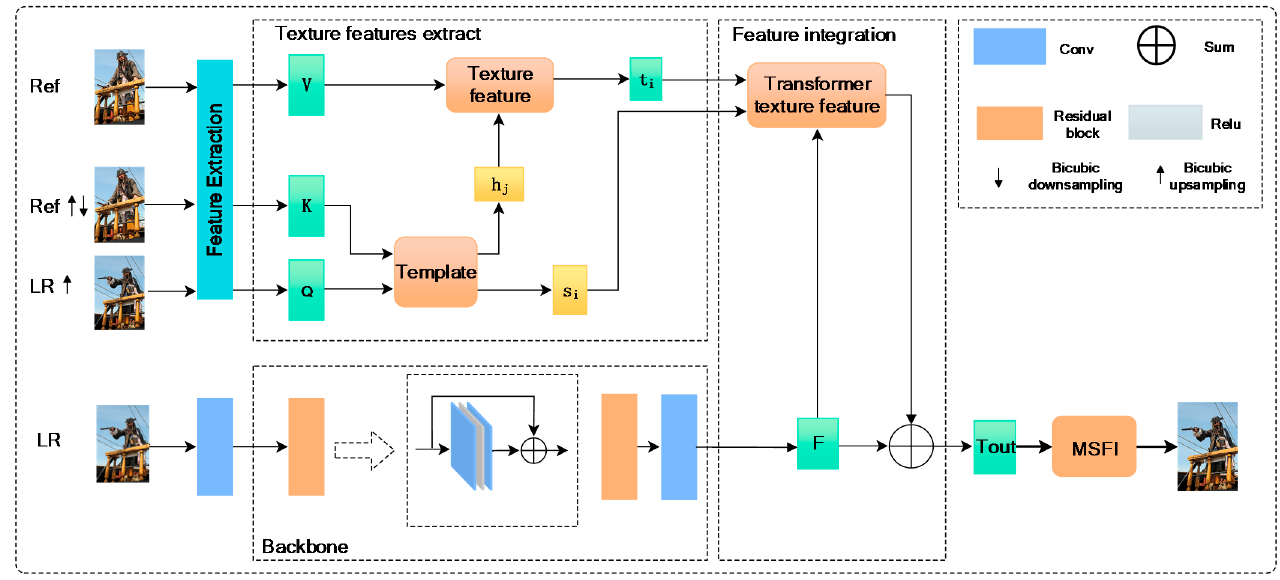
Figure 1. The architecture of the proposed enhanced texture transformer network (ETTN).